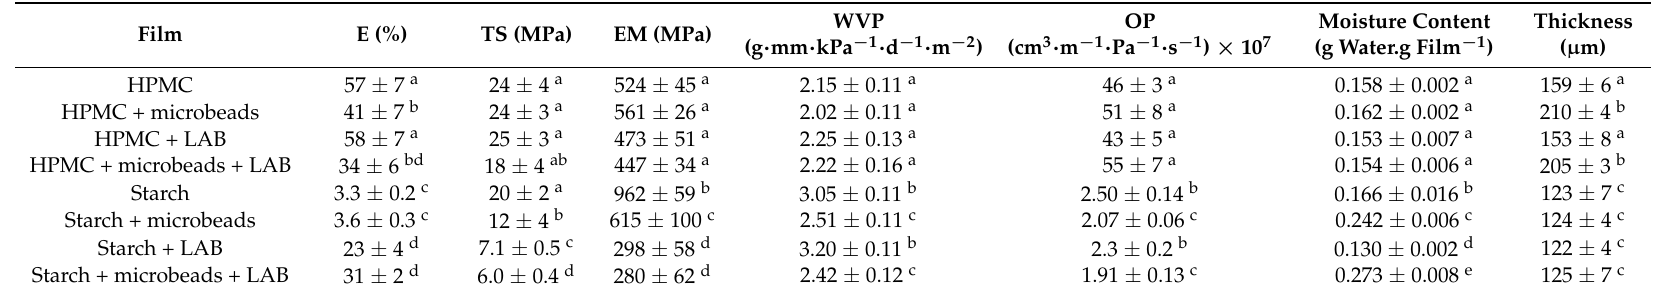
Table 1. Effect of the incorporation of LAB ( L. lactis ) and microbeads on mechanical properties (elongation at break (E%), tensile strength (TS) and elastic modulus (EM)), water vapour permeability (WVP), oxygen permeability (OP), moisture content and thickness of biopolymer films equilibrated at 5 ◦ C and 75% relative humidity. Mean values and standard deviation.